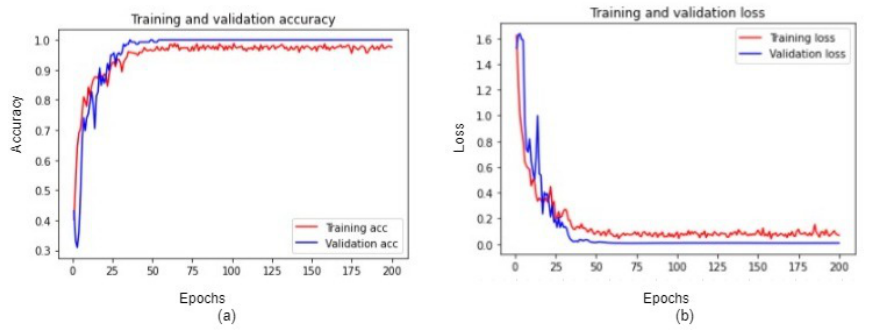
Figure 8. ( a ) Training & Validation accuracy on CK+ dataset ( b ) Training & Validation loss on CK+